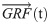

θ(t
1) determination to process the GRF→(t) components to split it in R→Passive nd the RActive→ algorithm: graphical description with θ generated by the swimmer in dashed-dotted curve and rigid articulated body in continuous curve (panel A) and raw algorithm flowchart (panel B).